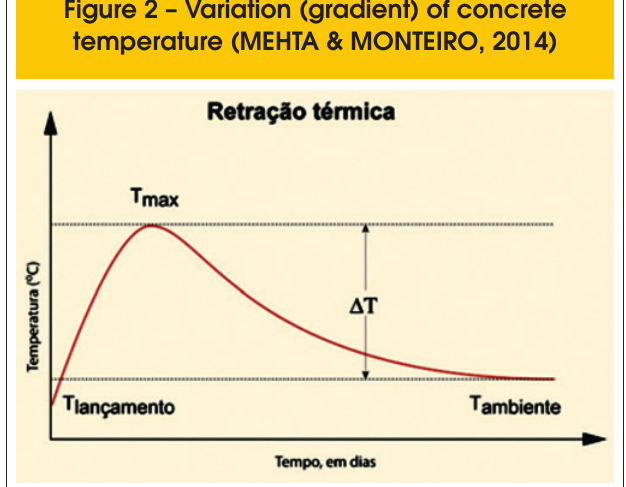
Figure 2 – Variation (gradient) of concrete temperature (MEHTA & MONTEIRO,